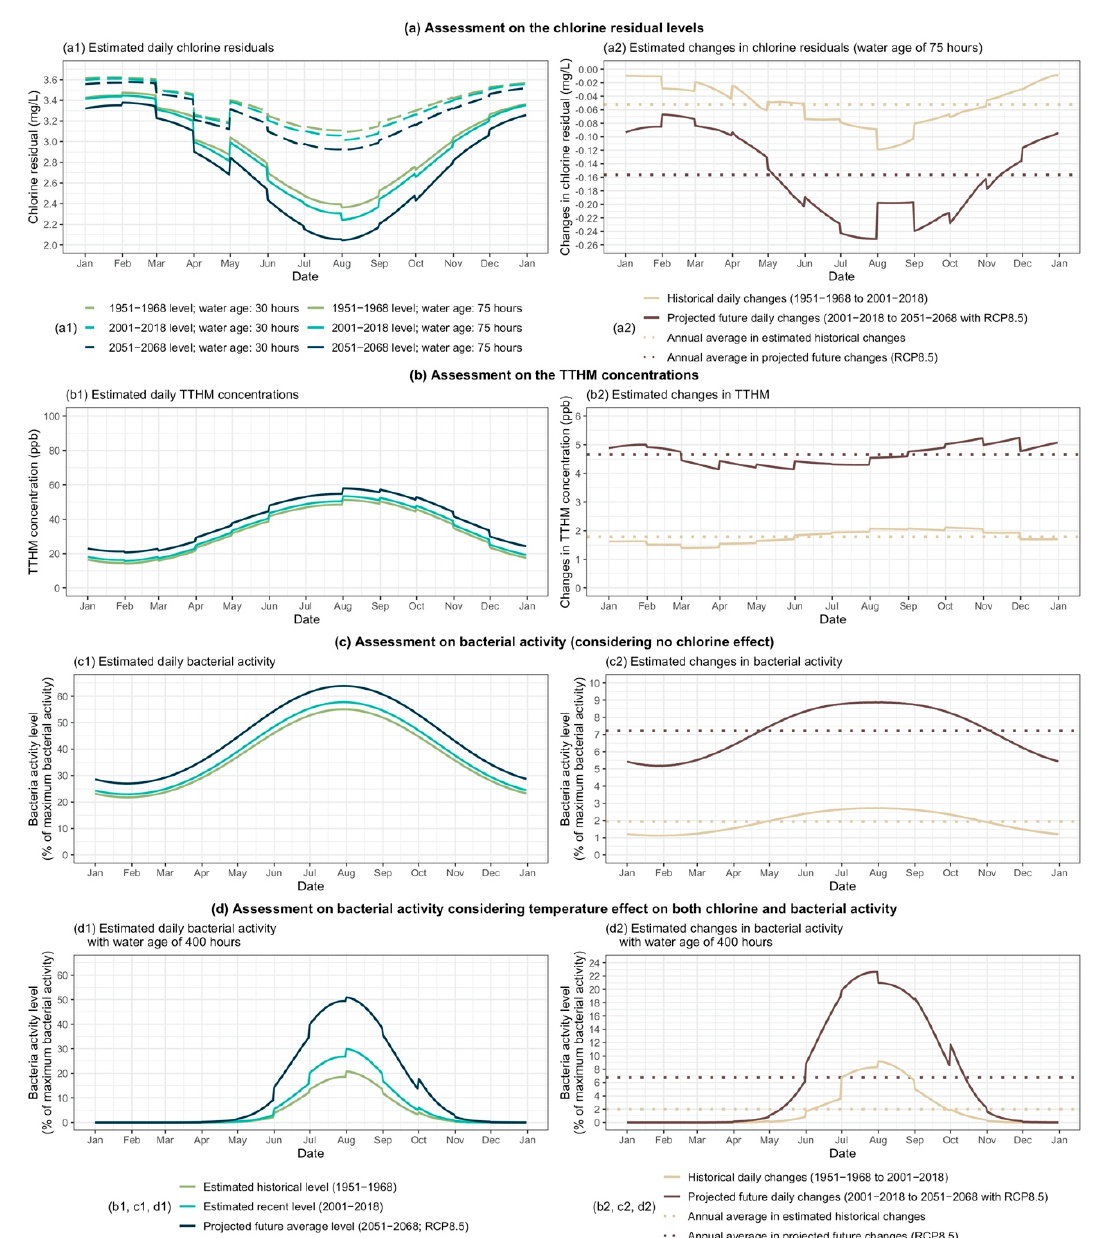
Figure 6. Estimated historical and projected water quality parameters and their changes for Washington D.C. with respect to daily ( a ) chlorine residuals with 30 h and 75 h water age values (considering only bulk decay); ( b ) TTHM concentrations in treated water; ( c ) bacterial activity (for fixed bacteria) considering no chlorine effect; and ( d ) bacterial activity (for fixed bacteria) considering the aggregate temperature effect on bacterial activity and chlorine residual (for a hypothetical location and an extreme case with a 400 h water age value). As monthly measurements of other required parameter values were kept the same and used for the daily calculation, the daily estimates exhibit sudden shifts in different months. The results of estimated bacterial activity are higher in part ( c ) than part ( d ) is because part ( c ) assumes no effect of chlorine.